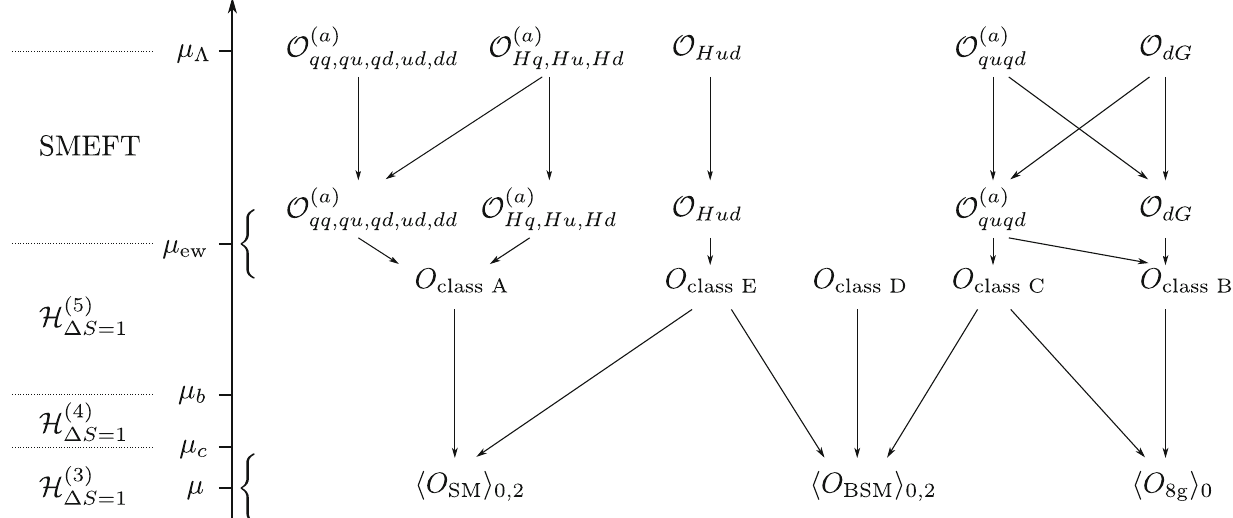
Fig. 1 Sketchofthedifferentcontributionsto ε (cid:2) /ε discussedinSect.2, by the K → ππ matrix elements (Sect. 2.1). In the SMEFT running, the arrows indicate operator mixing arising from top-quark Yukawa starting from Wilson coefficients of SMEFT operators at a high scale μ (cid:8) , evolved to the electroweak scale μ or gauge couplings. The matching is performed at tree level. We have ew with the SMEFT RG equa- omitted semi-leptonic and electro-magnetic dipole tions, matched onto the 5-flavour (cid:3) S = 1 effective Hamiltonian (Sect. 2.4), evolved to the hadronic scale μ (Sect. 2.2), and multiplied